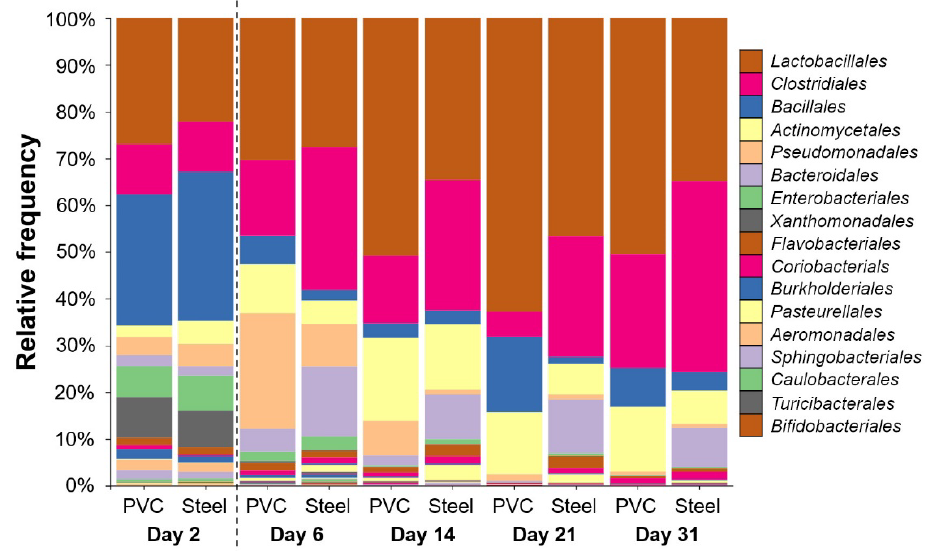
Figure 5. Taxonomic order profile of bacterial communities on the pig farm surface determined using PVC and steel coupons. Each color bar represents the relative frequency of one bacterial order inside the total bacterial community. For each day, PVC and steel taxonomic profiles are shown. The dotted line indicates the animal’s entry into the building.